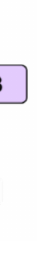
Figure 3. SRB (shallow residual